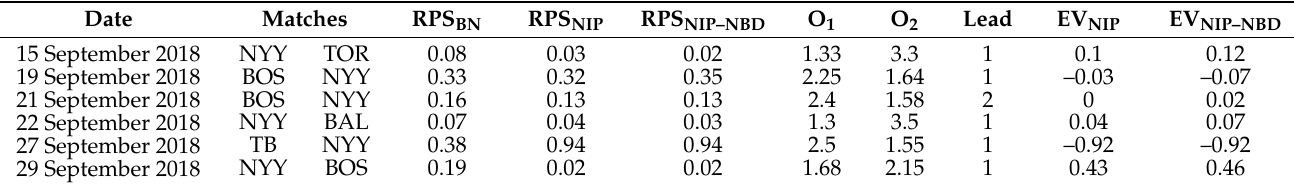
Table 4. Comparison of RPSs and EVs subject to BN, NIP and NIP–NBD for team New York Yankees